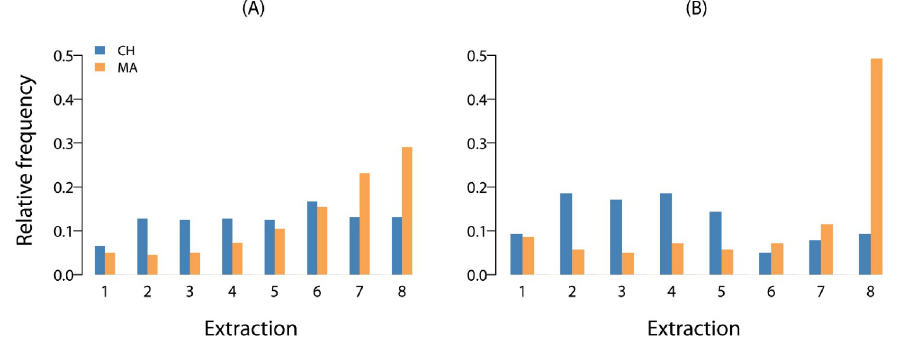
Fig 2. Choice frequencies. Relative frequency of chosen extract levels of fishers from Chwaka village (CH) and Marumbi village (MA) under (A) sociocultural homogeneity and (B) heterogeneity, aggregated over all rounds.